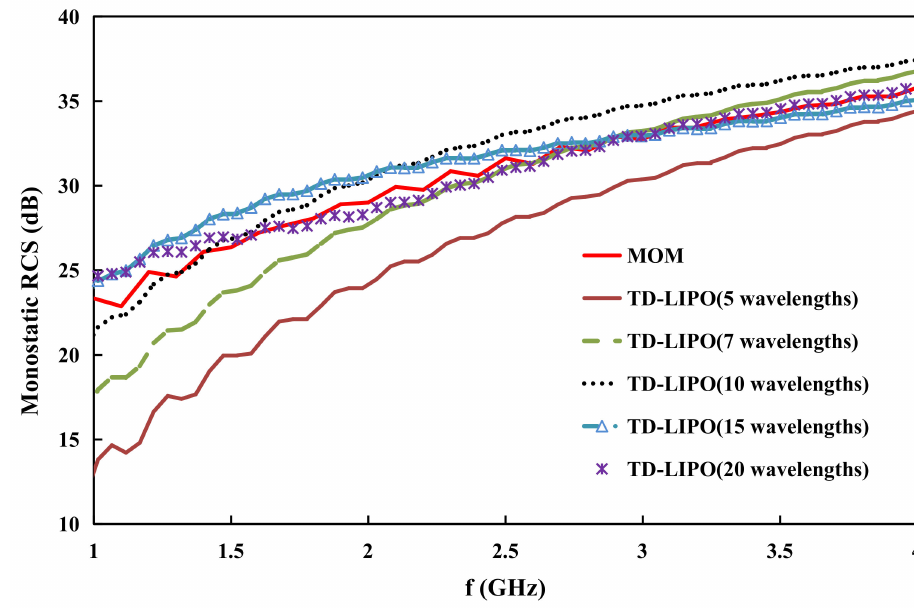
Figure 15. Monostatic RCS results for different size regions based on TD-LIPO